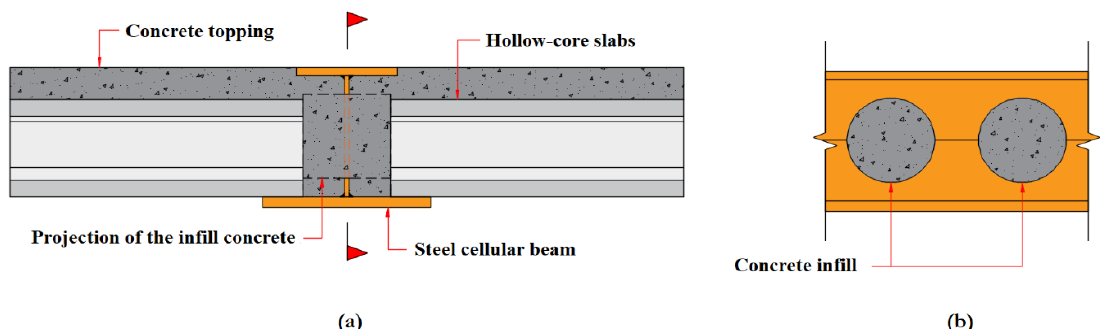
Fig. 3: Slim floor with precast hollow core slab and steel beam with web circular openings – (a) Cross section; (b) Section A -